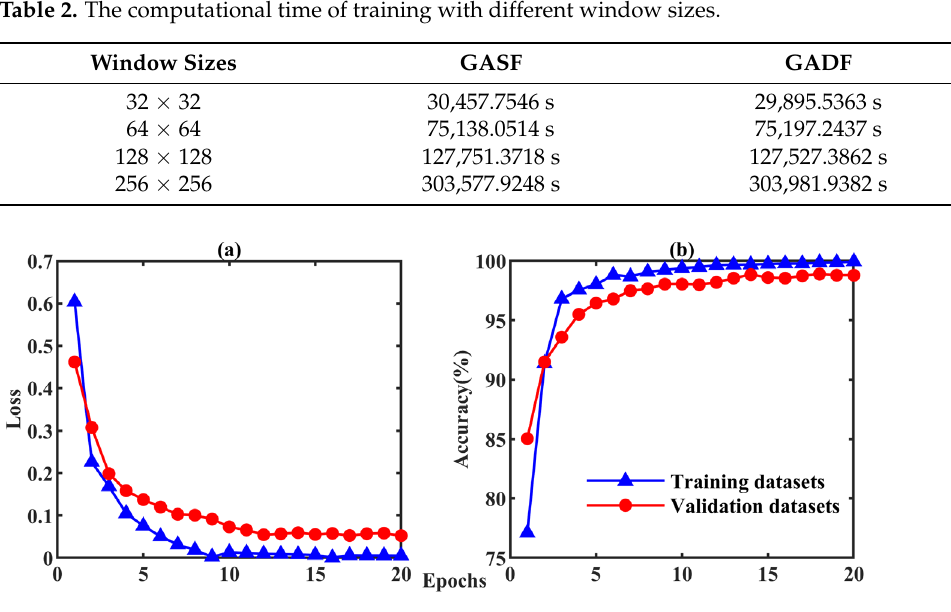
Figure 5. The loss and accuracy of the ResNet for MT noise identification. ( a ) Loss curves and ( b ) accuracy curves of training and validation datasets. Table 1. The identification accuracy of validation datasets with different window sizes.